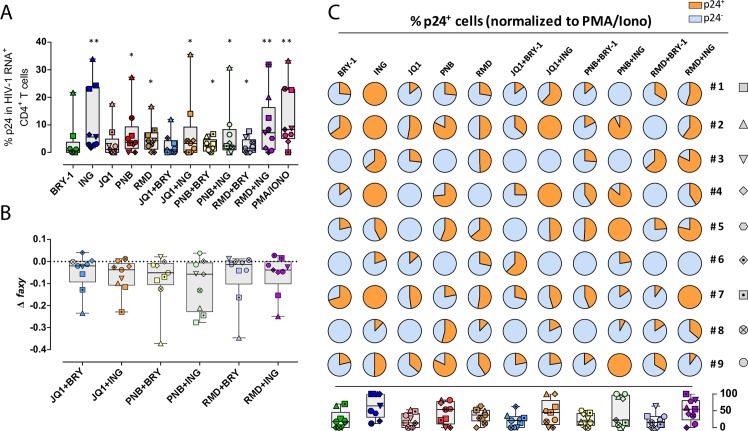
Proportion of CD4+ T cells expressing the viral protein p24 after viral reactivation with different LRAs.A. The proportion of HIV-transcribing CD4+ T cells that simultaneously produce the viral protein p24 is shown. Comparisons with the control medium were performed using the Wilcoxon test. *p<0.05, **p<0.01. B. Calculation of synergistic, antagonistic or additive effect after the combination of LRAs using the Bliss independence model. White symbols correspond to patients in which production of p24 was not detected. Medians and min to max ranks are represented in panels A and B. C. Normalization of the percentage of HIV-transcribing cells expressing p24 relative to PMA/Ionomycin. Pies for individual patients and median values for all patients are represented in a box and whisker plot graph. Fractions of HIV-1 RNA+ cells expressing p24 and lacking the expression of p24 are shown in orange and blue, respectively.